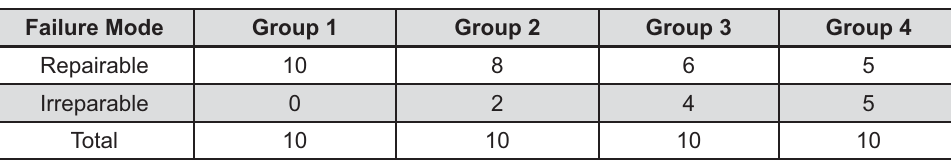
Figure 4- Frequency of failure mode after mechanical test